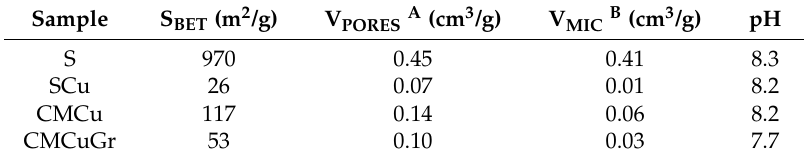
Table 1. Main textural parameters of the synthesized materials obtained from gas adsorption data.